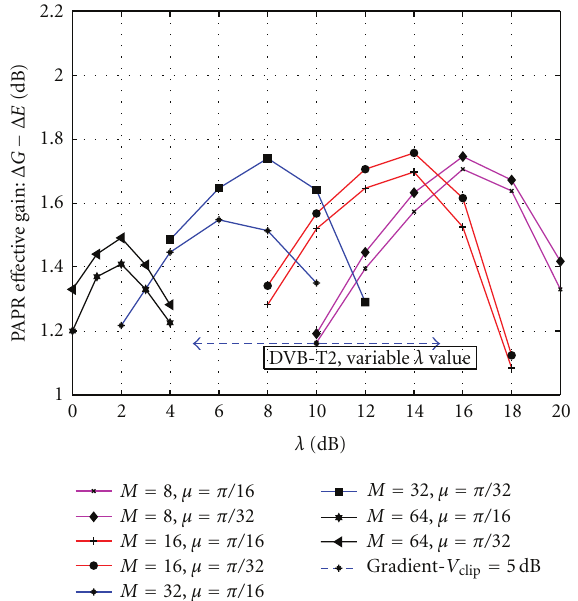
Figure 15: PAPR e ff ective gain: comparison between proposed and DVB-T2 TR techniques, 64-QAM.